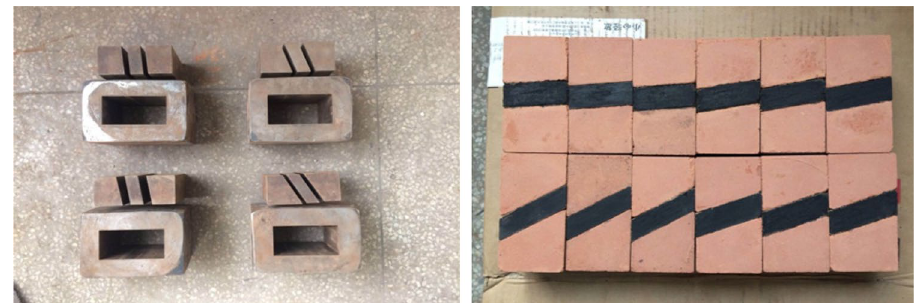
Figure 2. Specimen preparation molds and prepared specimens.